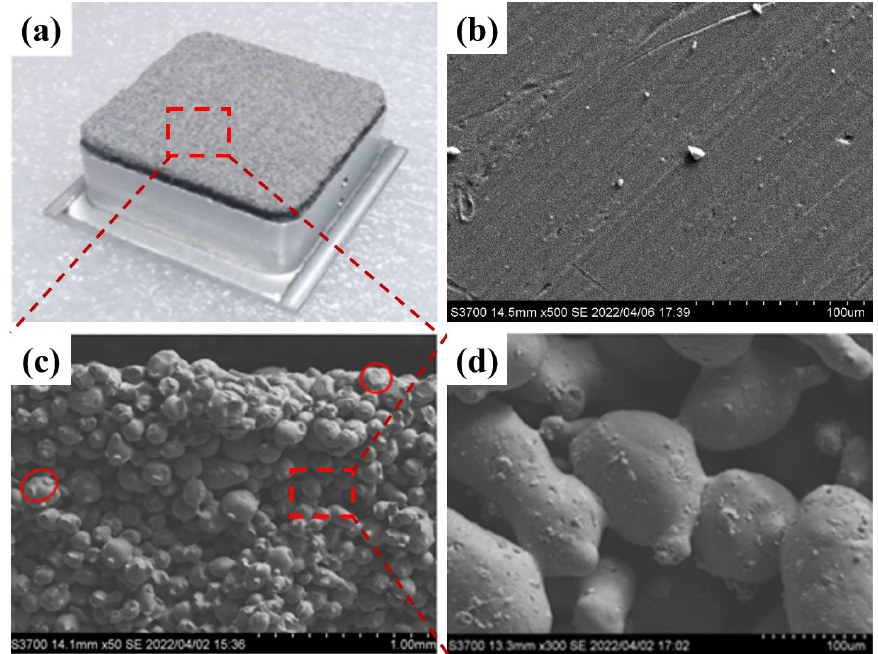
Figure 2. Image of aluminum wick: ( a ) Photos of sintered aluminum powder wick; ( b ) SEM image of polished aluminum plate; ( c , d ) SEM image of sintered aluminum powder wick.